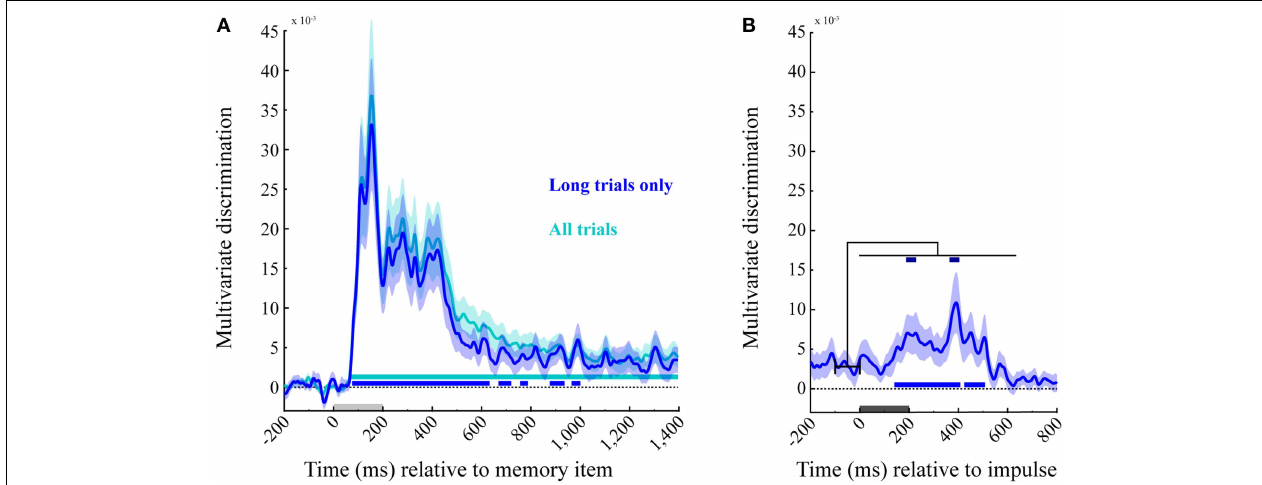
FIGURE 5 | Multivariate discrimination of the memory item across time. (A) Memory item epoch. The discrimination for both trial types (in cyan), and exclusively for the long trials used in the impulse response analysis (in blue). Significant positive clusters are marked with bars in the corresponding colors. (B) Impulse epoch. The discrimination of memory item is shown for long trials (in blue), with positive clusters are marked in the corresponding significance bar along the bottom. Significant increases in discrimination compared to the mean discrimination 100ms prior to impulse onset are indicated with dark-blue bars at the top. Light-gray and dark-gray bars represent memory item and impulse presentation, respectively. Error bars are standard deviations from the permuted